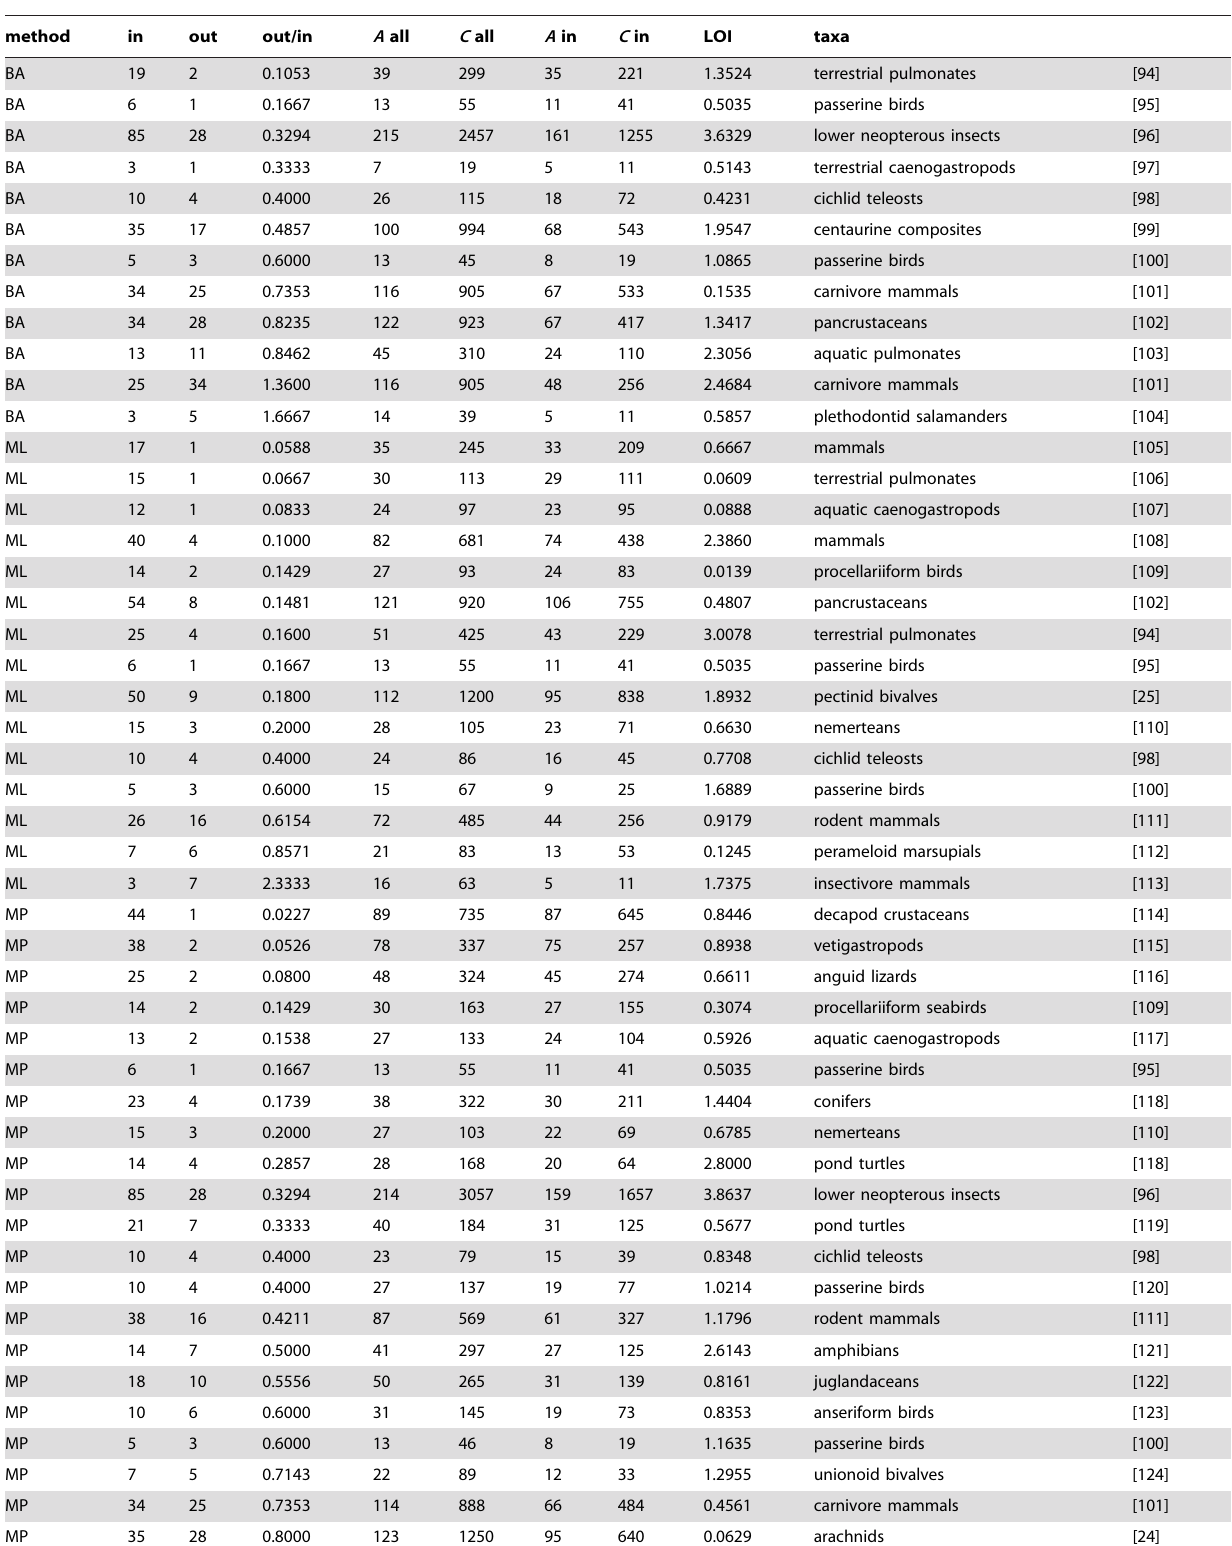
Table 3. Published phylogenetic trees analyzed. Trees are ordered by method of inference (BA =Bayesian, ML= maximum likelihood, MP= maximum parsimony, NJ =distance), proportion of outgroups relative to ingroup taxa (out/in), and log outgroup imbalance (LOI). Values of A and C are given for the complete trees and for ingroup taxa